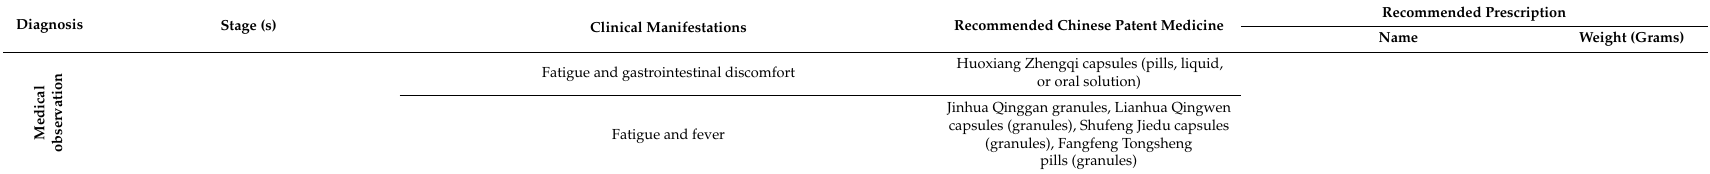
Table 2. Recommendations for treatment through Traditional Chinese Medicine for SARS-CoV-2-pneumonia